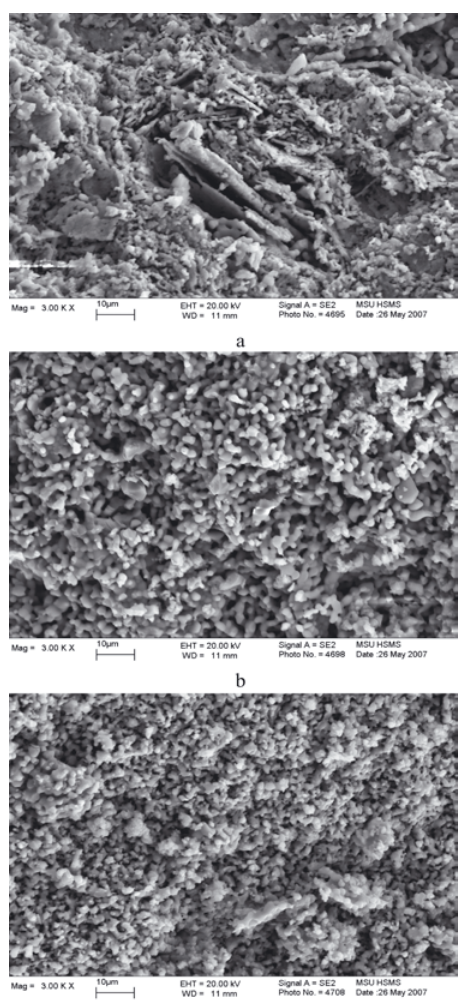
Figure 7. Micrographs of the samples from powders synthesized